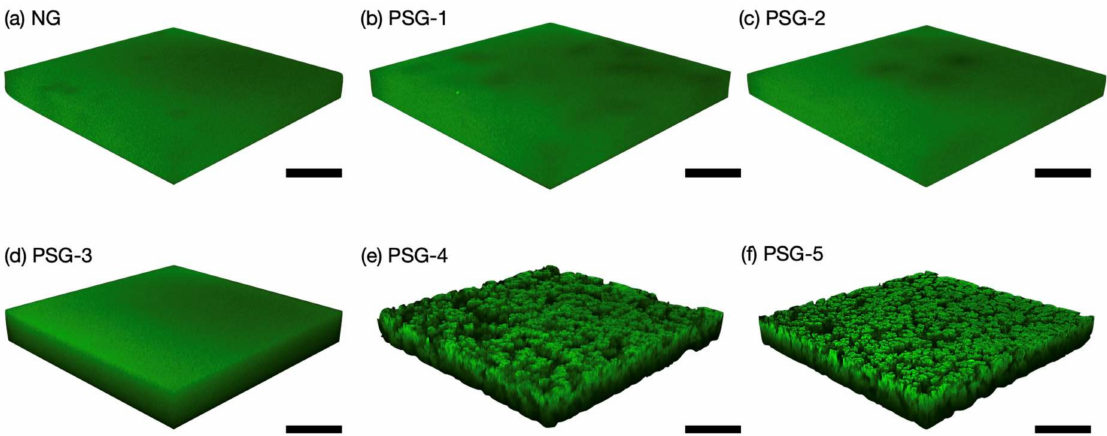
Figure 4. ( a – f ) Three-dimensional confocal laser scanning microscopy (CLSM) images of NG and PSGs at 20 ◦ C. Scale bar, 50 µ